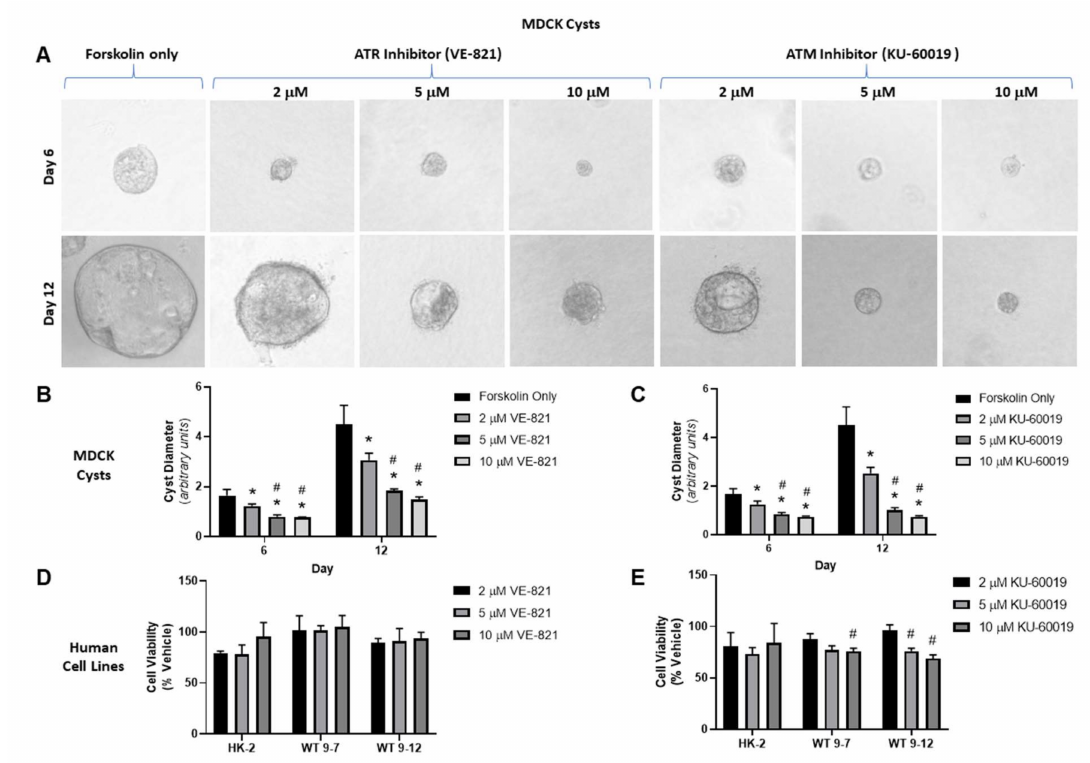
Figure 1. Effect of VE-821 (ATR inhibitor) and KU-60019 (ATM inhibitor) on three-dimensional (3D) Madin-Darby canine kidney (MDCK) cyst growth and cell viability (MTT assay) in human kidney tubular cell lines. ( A ) Representative images of MDCK cysts treated with forskolin alone, VE-821 (2, 5, and 10 µ M) or KU-60019 (2, 5, and 10 µ M) on Days 6 (upper panel) and 12 (lower panel) (Images were obtained using 10x objective). ( B ) and ( C ) Mean cyst diameter of MDCK cysts on Days 6 and 12, treated with either VE-821 or KU-60019 as determined by image analysis; ( D ) and ( E ) Mean number of viable cells (as a percentage of vehicle, measured by the MTT assay) in HK-2, WT 9-7, and WT 9-12 cells treated with either VE-821 (2, 5, and 10 µ M, ( D )) or KU-6001 (2, 5, and 10 µ M, ( E )) for 24 h. * p < 0.05 compared to forskolin alone, # p < 0.05 compared to 2 µ M by one-way ANOVA, followed by post hoc analysis with the Tukey–Kramer HSD test. Data presented as means ± SD ( n = 3 per